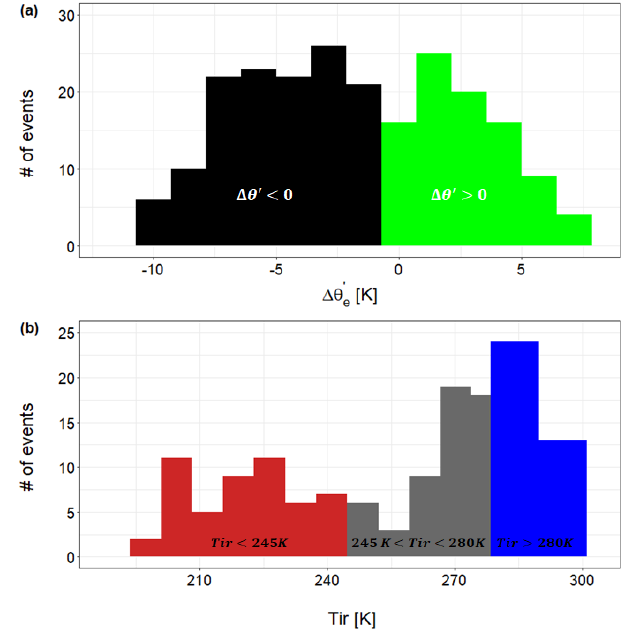
Figure 9. Histograms of (a) the values of (cid:49)θ (cid:48) e at the beginning of the particle growth events. Black bars represent events during down- draft conditions and the green bars during undefined conditions. (b) The values of Tir at the beginning of the particle growth events. Red bars represent events during deep-convection conditions, blue during clear-sky/shallow-cloud conditions, and gray during mixed- sky